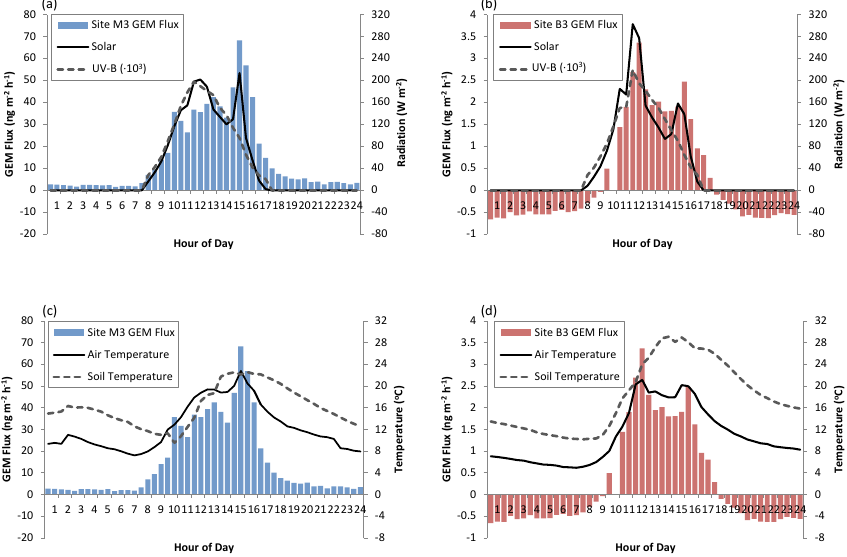
Fig. 3. Diel composite GEM flux, radiation and temperature data from June study. Top graphs compare GEM flux with radiation measure- ments taken over a mercuriferous (a) and background (b) site. Bottom graphs compare GEM flux with temperature measurements taken over a mercuriferous (c) and background (d)